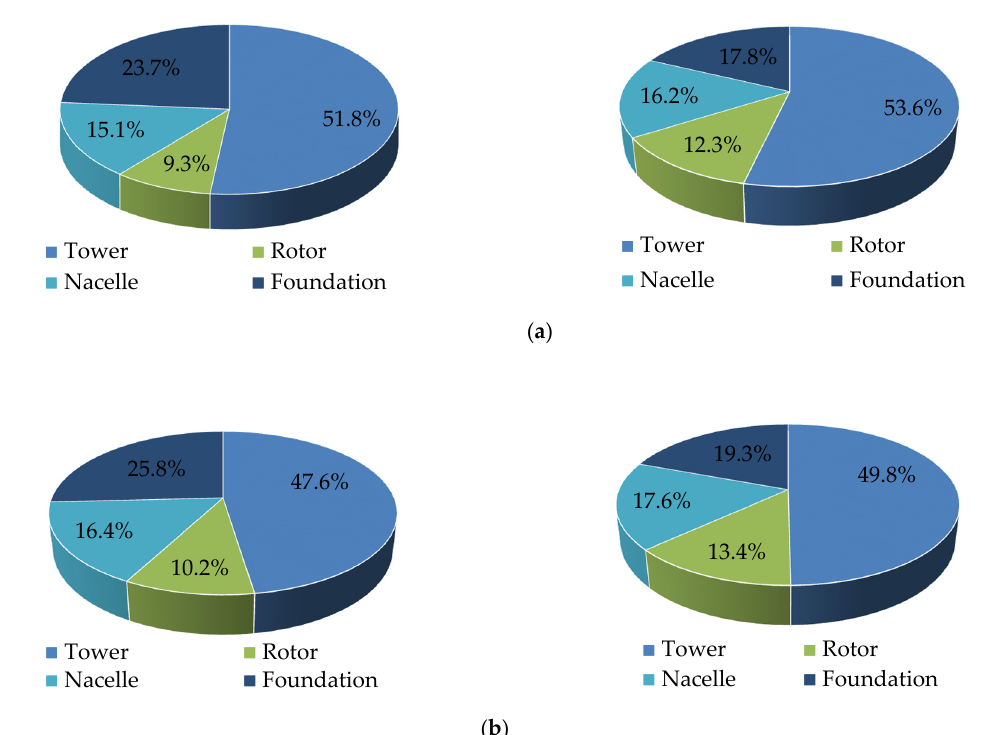
Figure 7. Contribution of each component. ( a ) 6-legged, ( b ) 4-legged.